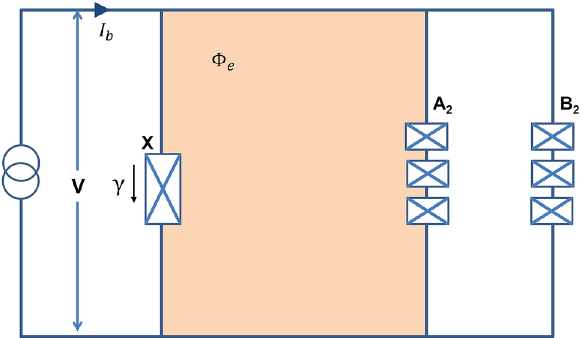
Figure 7. The Josephson-junction circuit with flux qubits designed by Wang et al. 47 for implementing the J-measurement. Each flux qubit labeled as A 2 and B 2 consists of three small junctions. (cid:31) e is the flux of the external magnetic field threading the loop connecting the larger junction “0” and A 2 qubit. Following the implementation of QZD, qubits A 2 and B 2 will be measured in z -basis, leaving qubits A 1 and B 1 entangled, i.e., the entanglement swapping procedure is